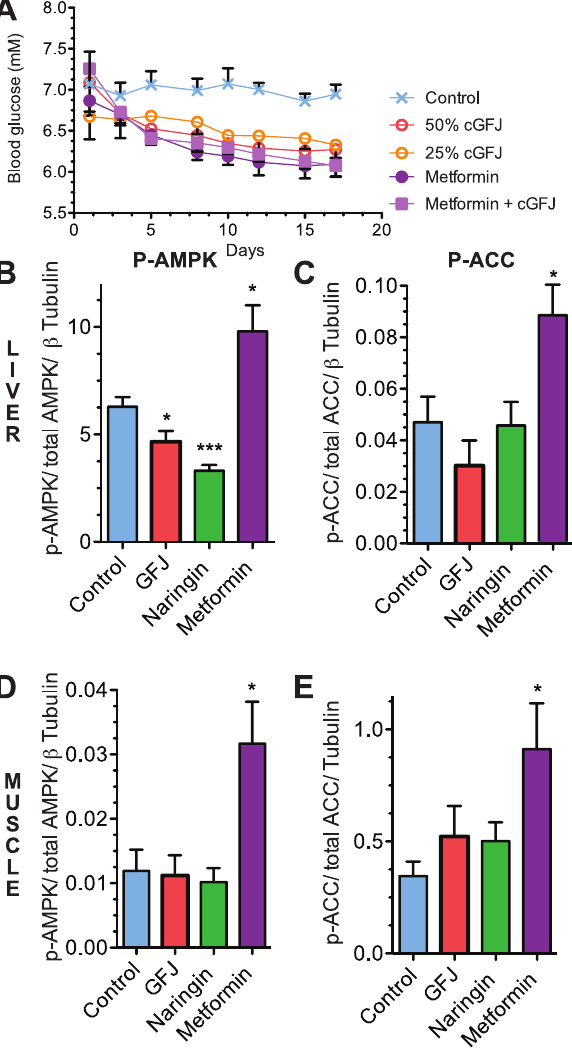
Figure 7. Effects of cGFJ on serum glucose levels and on AMPK and ACC phosphorylation in muscle and liver. Mice were fed a HFD. A) Blood glucose levels during 17 d access to 50% cGFJ, 25% cGFJ, metformin, metformin and 50% cGFJ, or water. B-E) Mice were allowed access to 50% GFJ, naringin or metformin in control water for 106 d starting at weaning: B) liver pAMPK/AMPK, * P , 0.04, *** P =0.0002; C) liver pACC/ACC, * P , 0.03; D) muscle pAMPK/AMPK, * P , 0.03; E) muscle pACC/ACC, P , 0.03. Phospho- and total protein were determined by western blot and normalized to tubulin. A two-tailed, unpaired t-test was used to determine statistical significance.